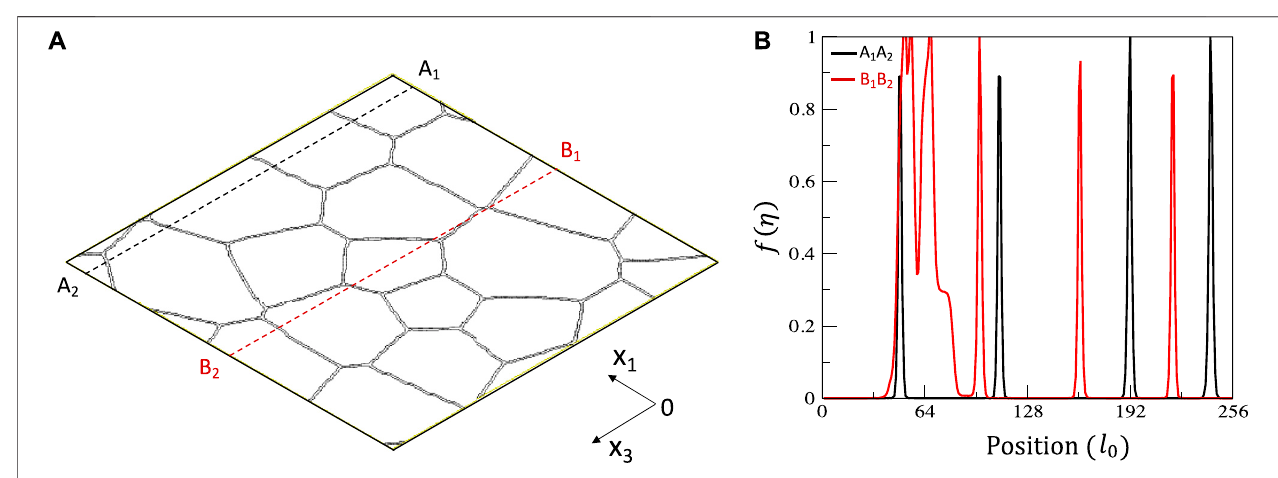
FIGURE 1 | (A) the polycrystalline structure used in the simulations and (B) the shape function f ( η ( x 3 )) along the lines A 1 A 2 and B 1 B 2 shown in (A) . Figure 3 , where the dashed lines mark the locations of grain boundaries.